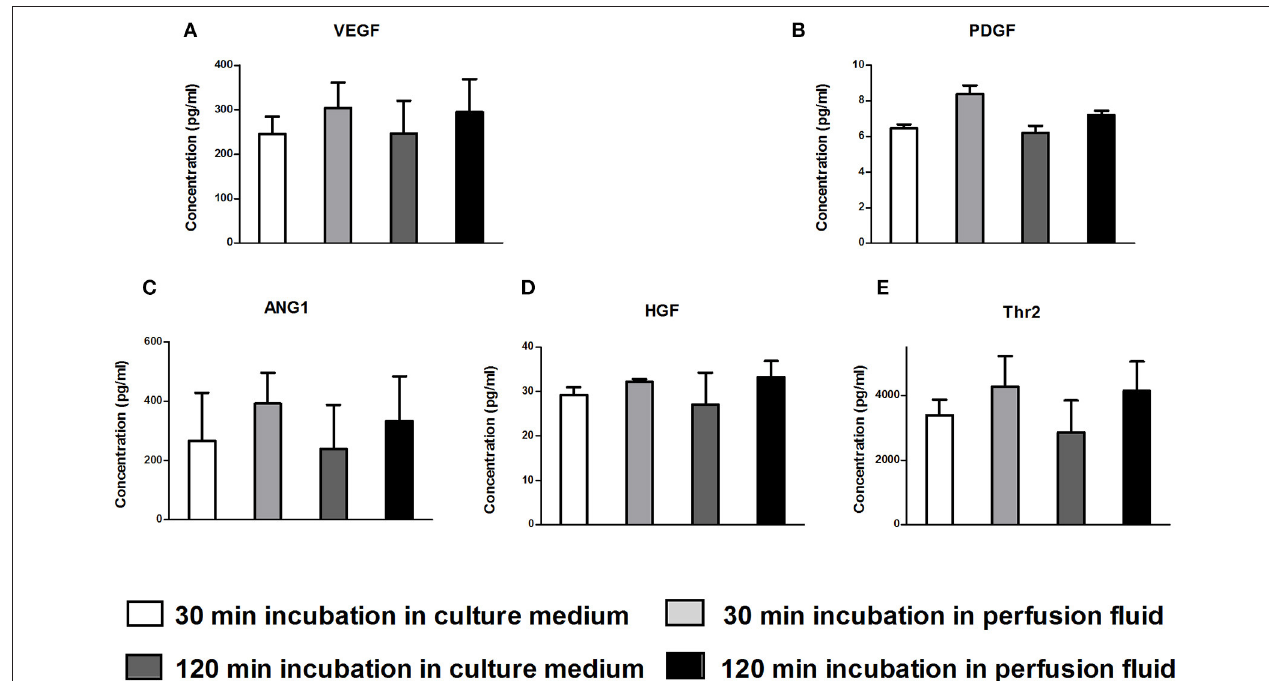
FIGURE 7 | Production of angiogenic factors by hMSC in culture medium and perfusion fluid. MSC were incubated in perfusion fluid for 30 or 120min, washed and replaced by culture medium for 24h. The secretion of angiogenic and growth factors was not affected by perfusion fluid. (A–E) Concentration of secreted VEGF, PDGF, ANG1, HGF and Thr2, respectively ( n = 5). Results are shown as mean ± SD.